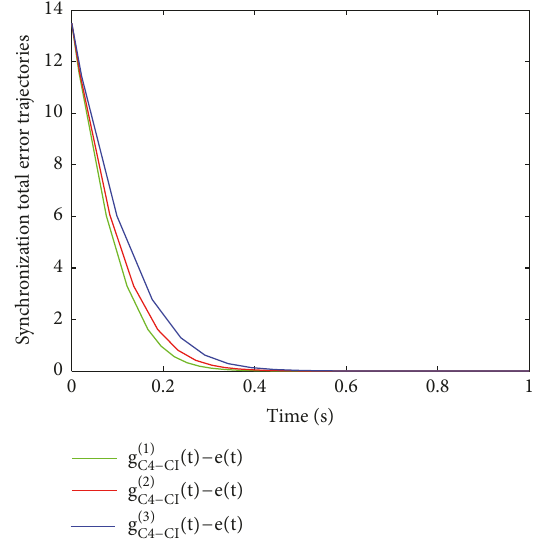
Figure 8: Synchronization total error trajectories of the network (36) for the case II of Corollary